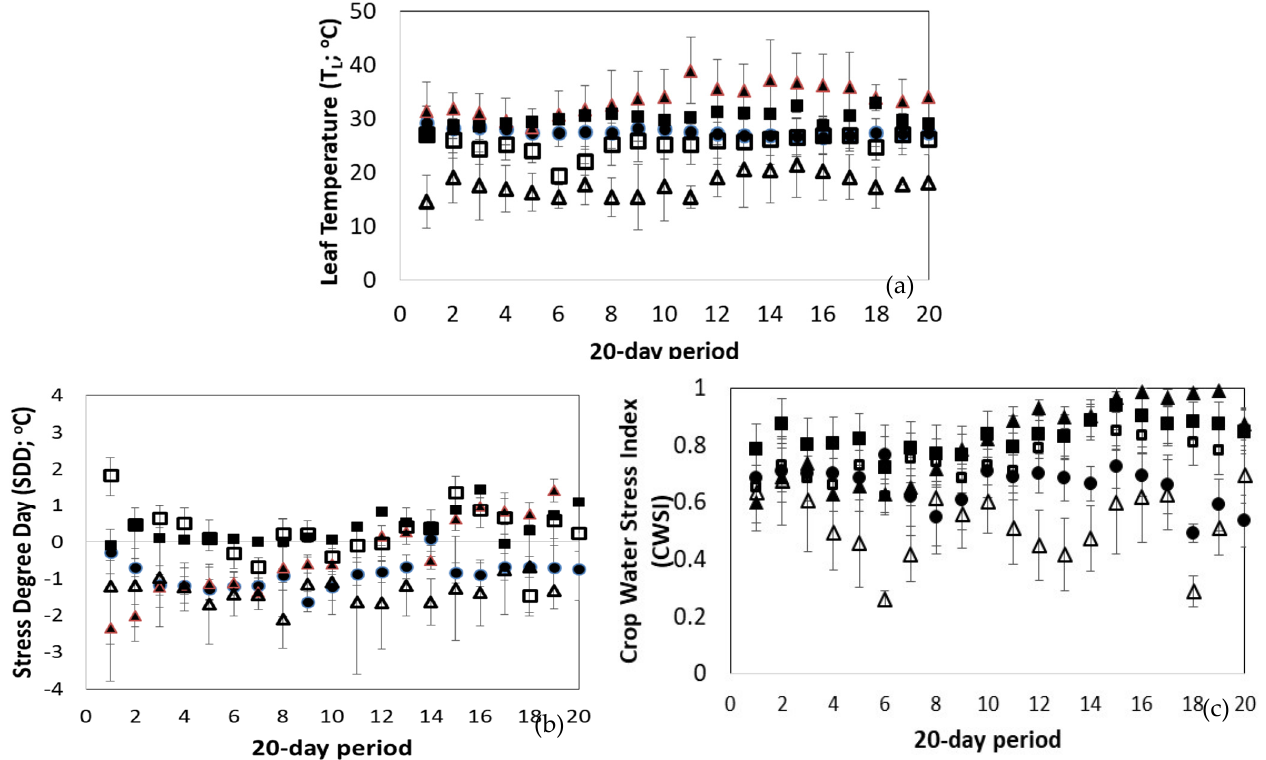
Figure 6. The mean daily values and their standard deviation of ( a ) Leaf Temperature (T L , ◦ C), ( b ) Stress Degree Day (SDD; ◦ C) and ( c ) Crop Water Stress Index (CWSI) according to the treatment during the 20-day period. Solid circle: NoS; Empty triangle: LTS; Solid triangle: HTS; Solid square: LNS; Empty square: LWS.